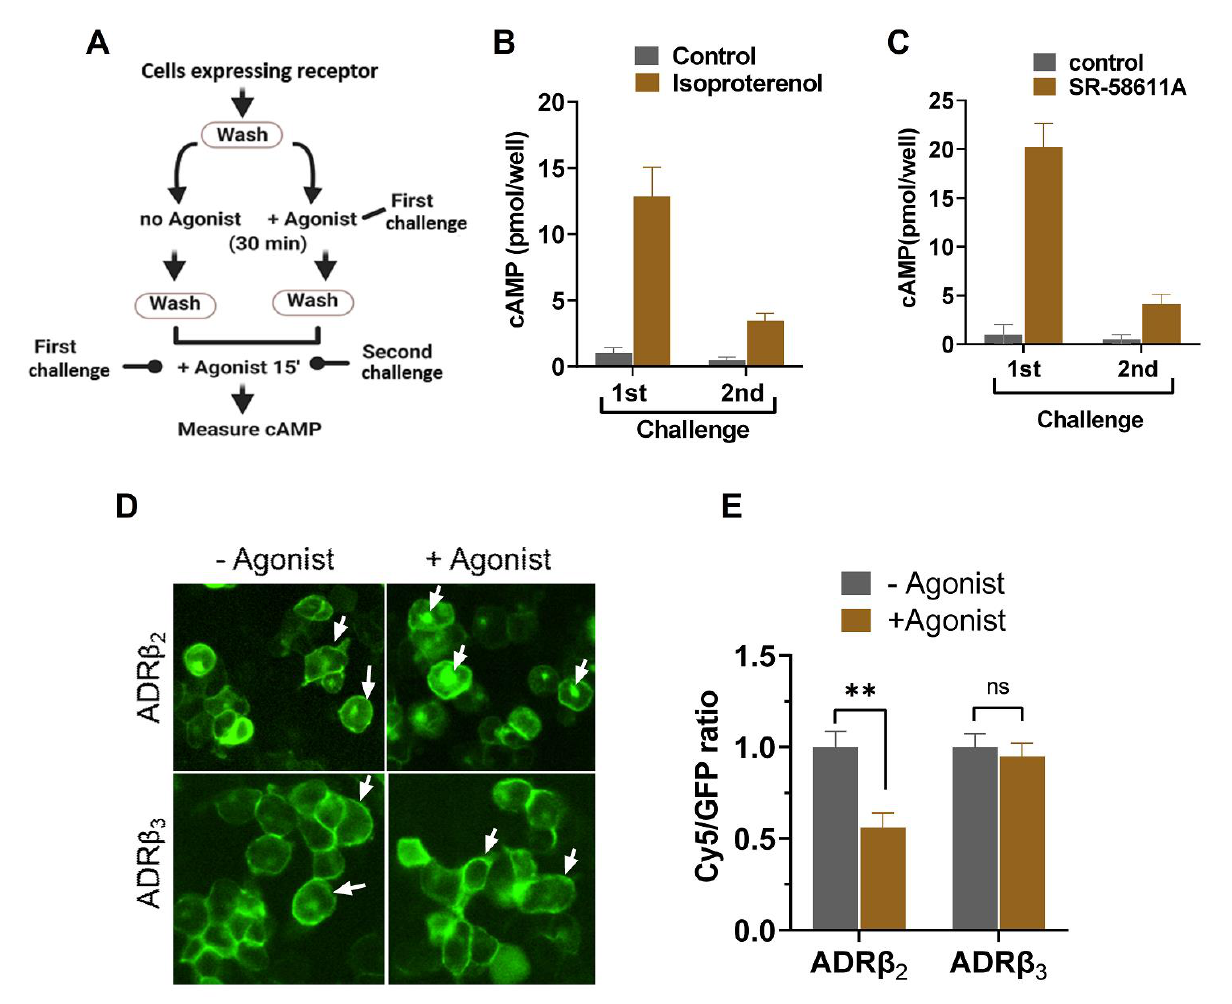
Figure 4. Agonist-induced desensitization of ADR β 2 and ADR β 3. ( A ) Experimental outline to measure agonist-induced desensitization of ADR β 2 and ADR β 3. ( B ) cAMP formation in cells expressing ADR β 2 after 1st or 2nd challenge with isoproterenol. ( C ) cAMP formation in cells expressing ADR β 3 after 1st or 2nd challenge with SR-58611A. ( D ) Fluorescent images of cells showing expression of HA-ADR β 2-GFP and HA-ADR β 3-GFP without and with agonist stimulation. ( E ) Graph showing surface to total cellular expression (Cy5/GFP) of ADR β 2 and ADR β 3 with or without agonist stimulation. Each bar represents an average of three independent experiments. ** p < 0.01 and ns p > 0.05.